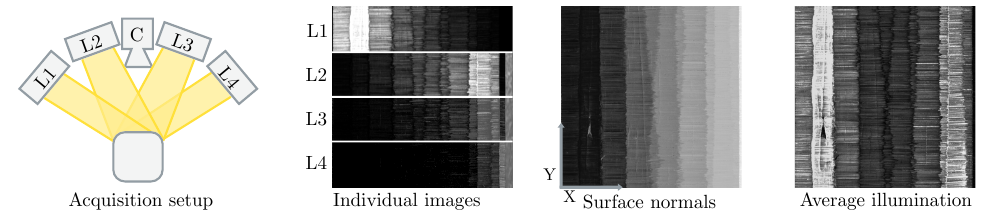
Figure 2. Acquisition setup for photometric stereo surface data. Using a setup consisting of a camera (C) and four line-light sources (L1,..., L4) arranged perpendicular to the steel billet’s trans- port direction ( left ), image data of individual light sources is acquired ( middle-left ). Using the photometric stereo algorithm, we obtain surface normals ( middle-right ). Compared to averaged image data obtained from the same setup ( right ), we observe substantially diminished horizontal grinding